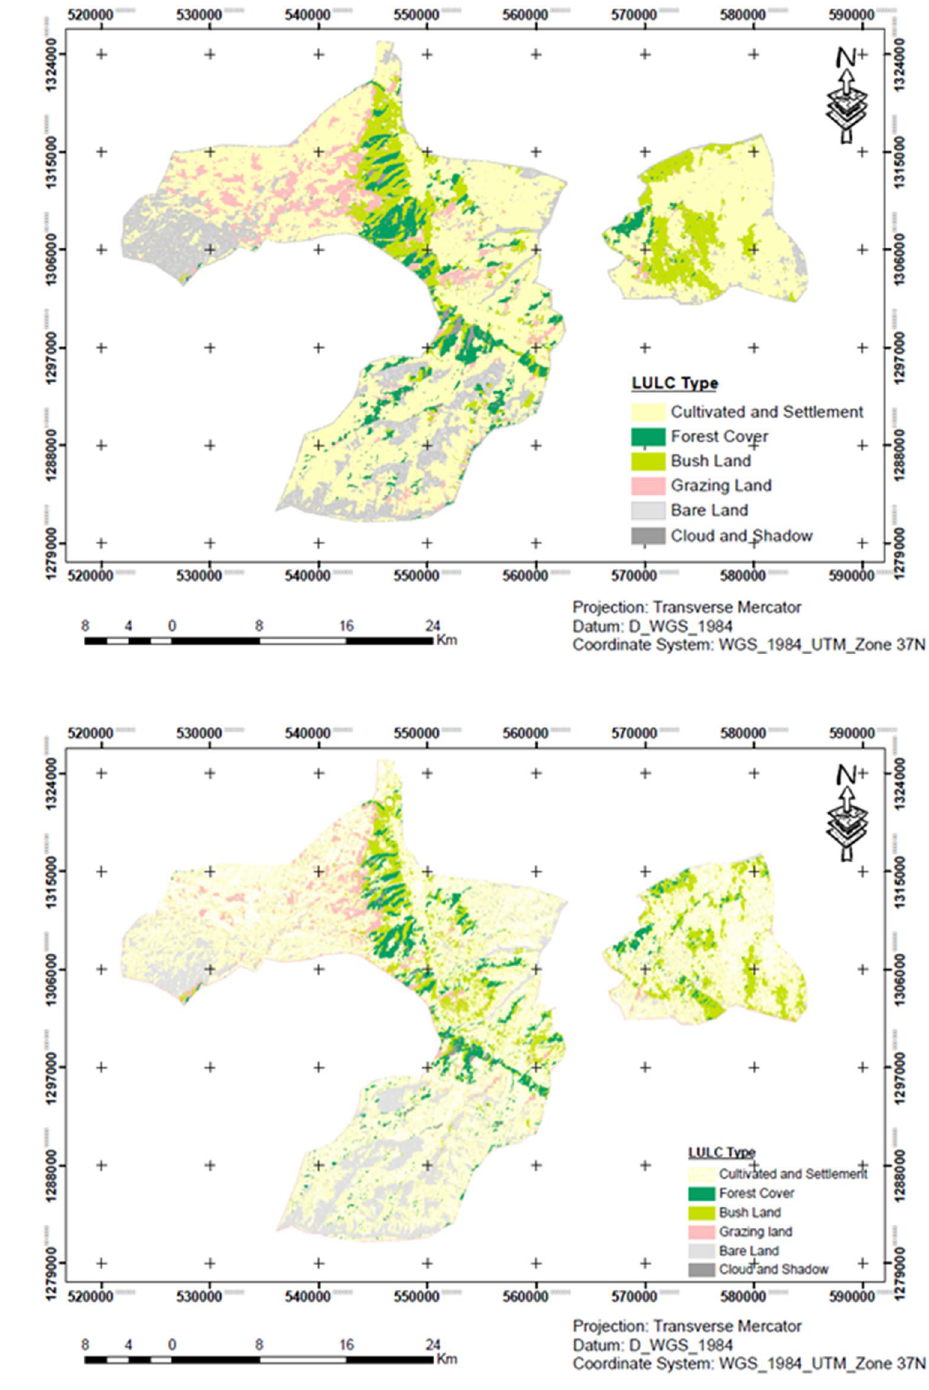
Fig. 2 LULC map of Gubalafto District in 1986